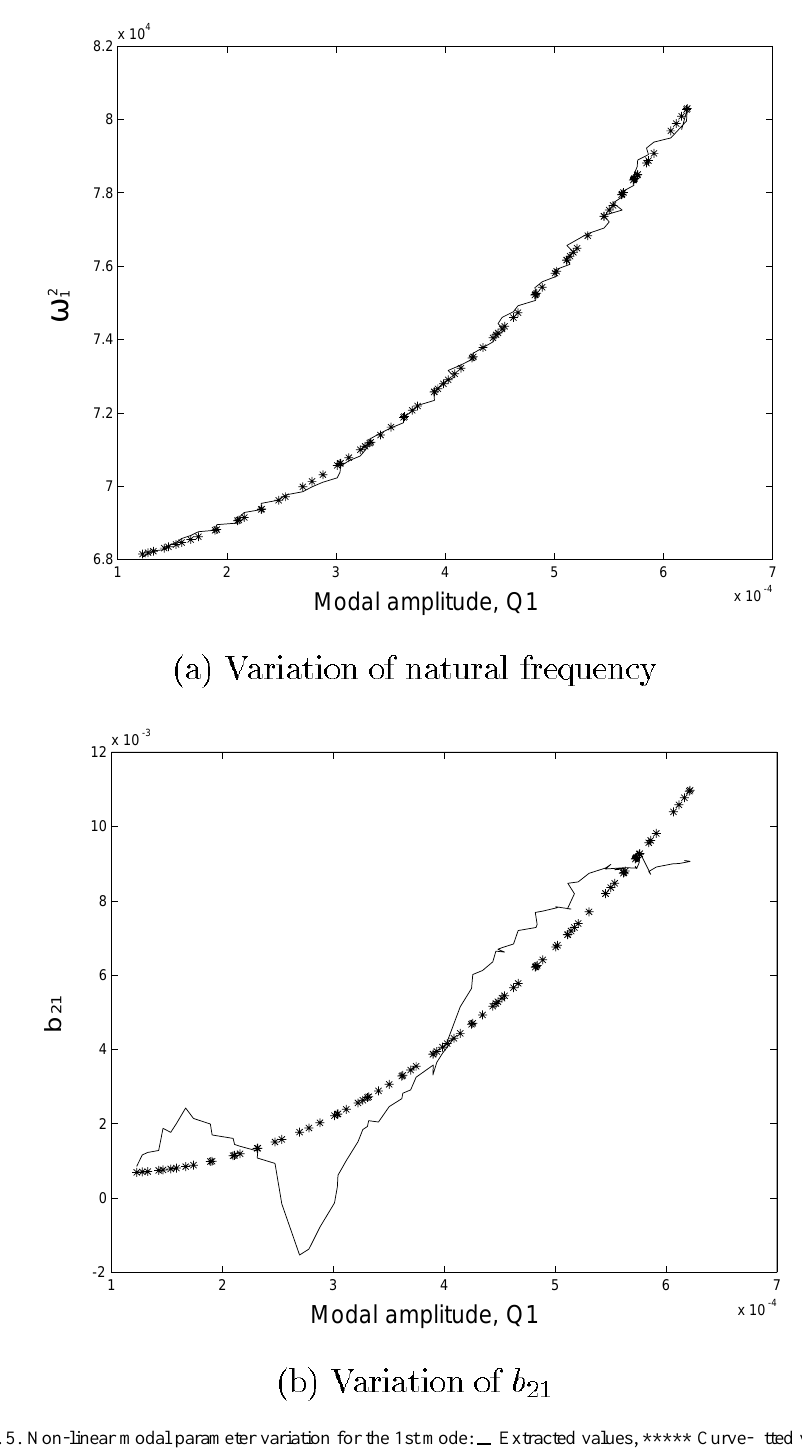
Fig. 5. Non-linear modal parameter variation for the 1st mode: Extracted values, ***** Curve-fitted